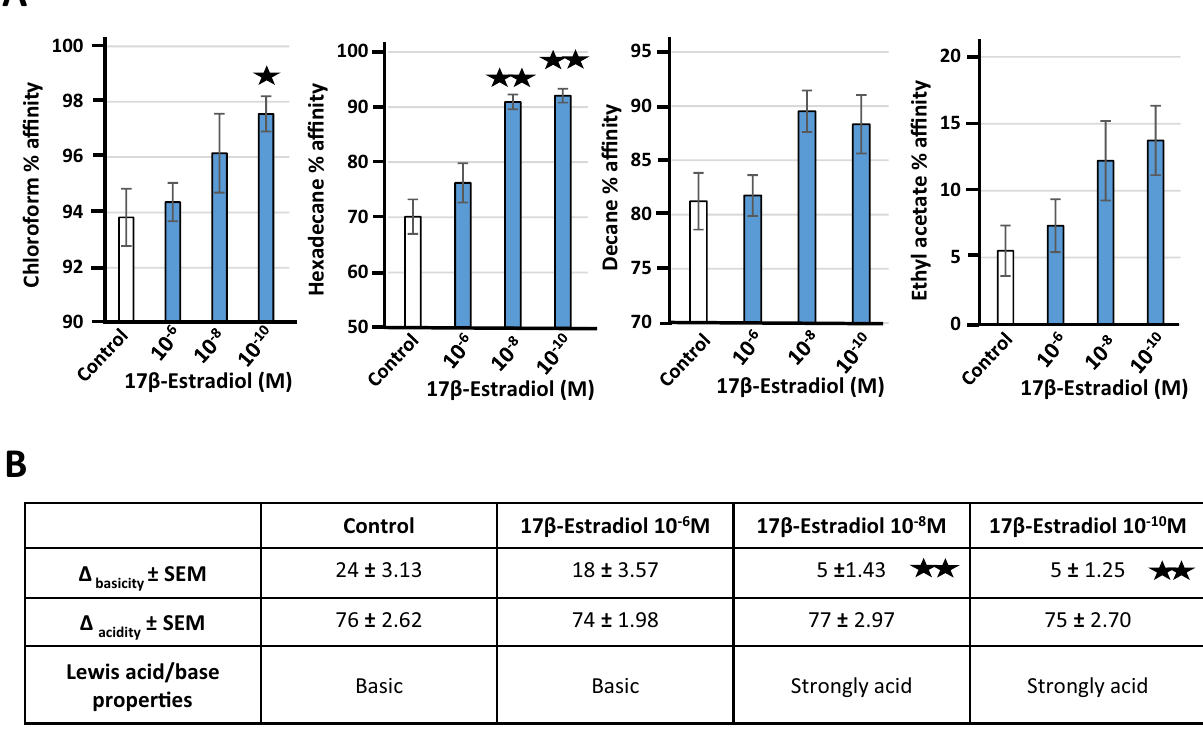
Figure 4. Effect of 17β-estradiol (10 –6 , 10 –8 , and 10 –10 M) on the affinity for solvents and Lewis acid/base surface properties of Lactobacillus crispatus V4. ( A ) Partition between water and chloroform, water and hexadecane, water and decane, and water and ethyl acetate. ( B ) Lewis acid/base behavior of L. crispatus V4 with the two solvent couples hexadecane (HD)/chloroform (CH) and decane (DE)/ethyl acetate (EA). Values are the means ± SEM of three independent studies ( p < 0.05, p < ★ ★★